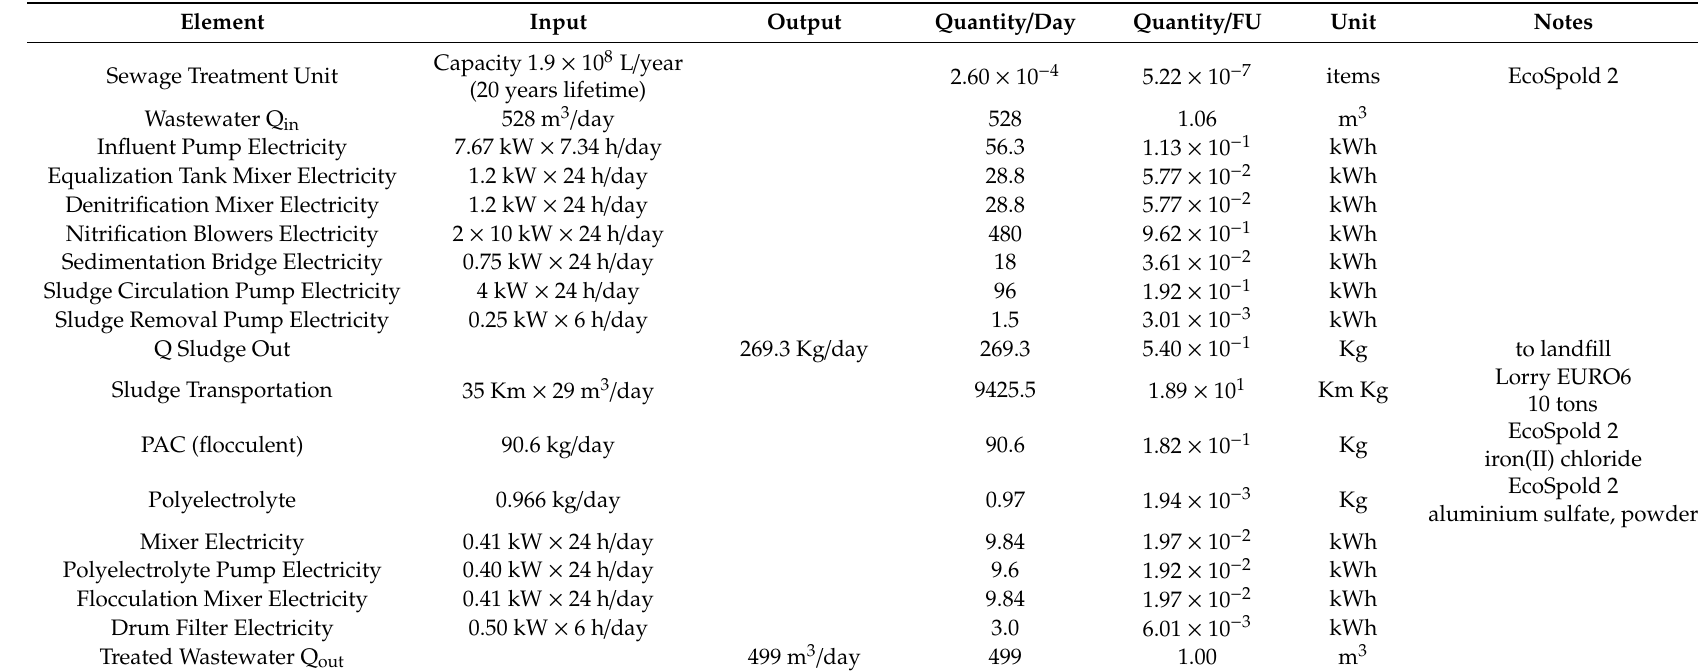
Table 2. Conventional activated sludge unit